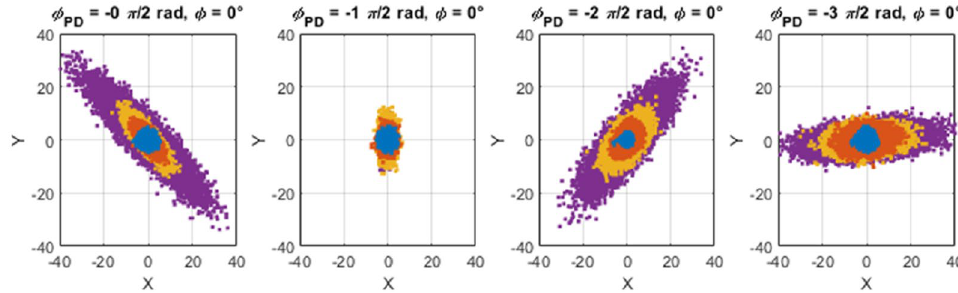
Figure 4. Experimental distribution of X and Y values as function of the parametric phase (φ PD ) and gain ( h from from 0 to ~ 0.8, blue-yellow-orange-purple), for noise-driven deflection in open-loop configuration.